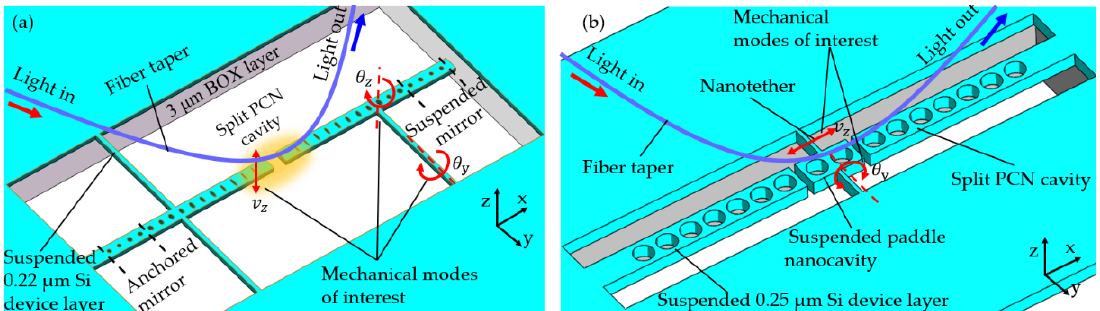
Figure 19. PCN nanocavity torque sensors: ( a ) photonic crystal split-beam nanocavity [124] ; ( b ) photonic crystal paddle optomechanical cavity [126] . crystal paddle optomechanical cavity [126].